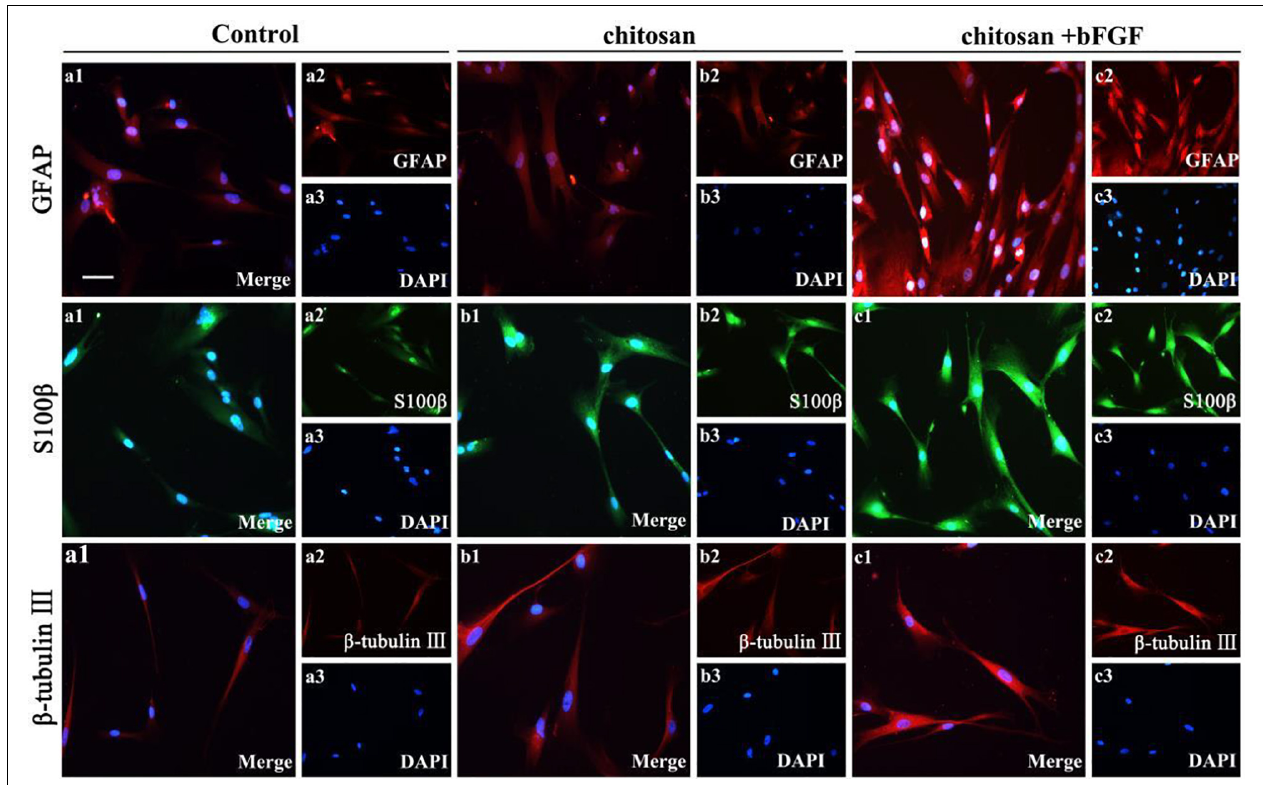
FIGURE 7 | Schematic illustration of the preparation and application of the CS/ β -GP/gelatin hydrogels. Reproduced from Xu et al. (2019) with permission from Copyright 2019